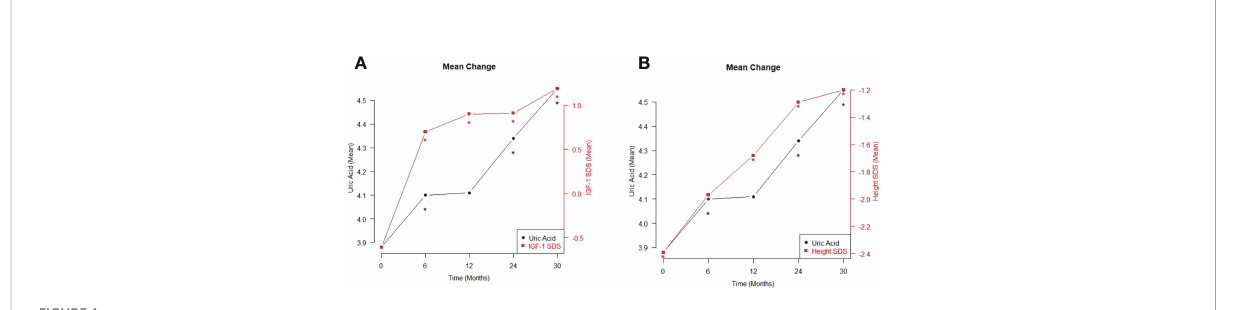
FIGURE 1 The mean changes in between uric acid and IGF-1 SDS (A) , and between uric acid and height SDS (B) during the period of growth hormone treatment * p <